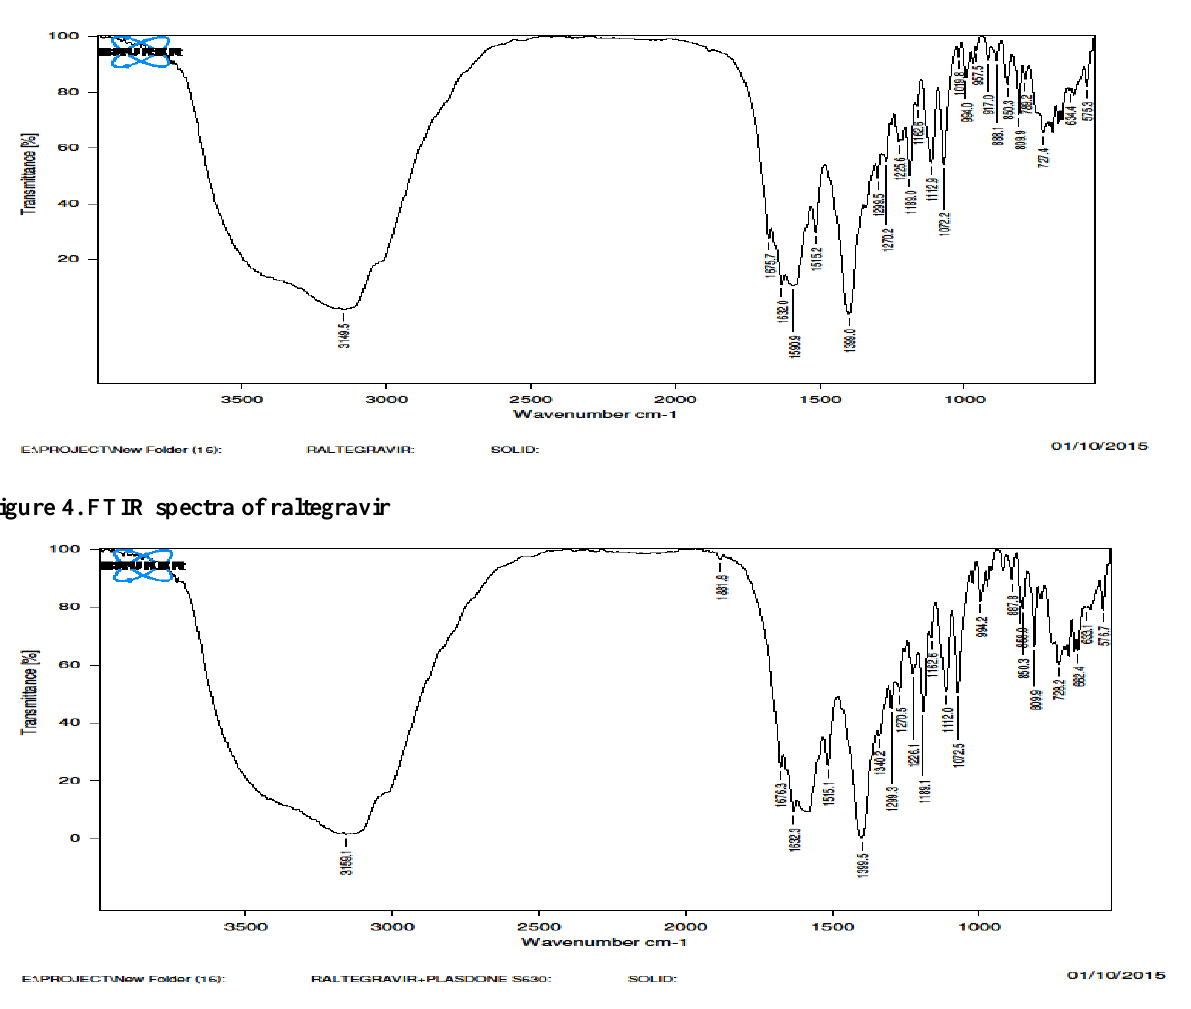
Figure 5. FTIR of physical